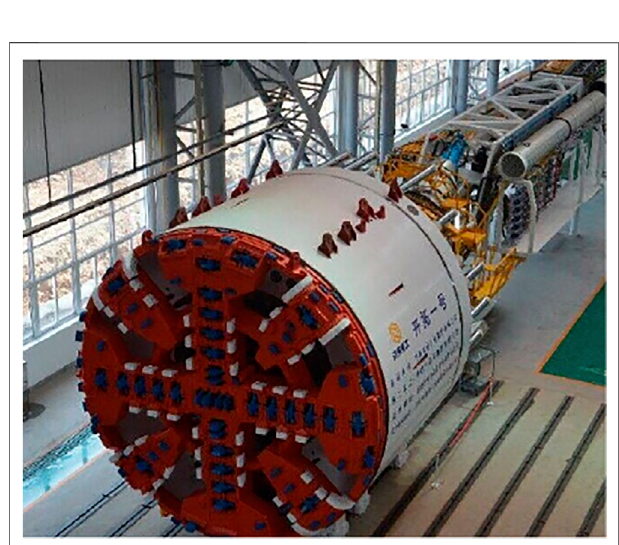
FIGURE 4 | The used EPB shield